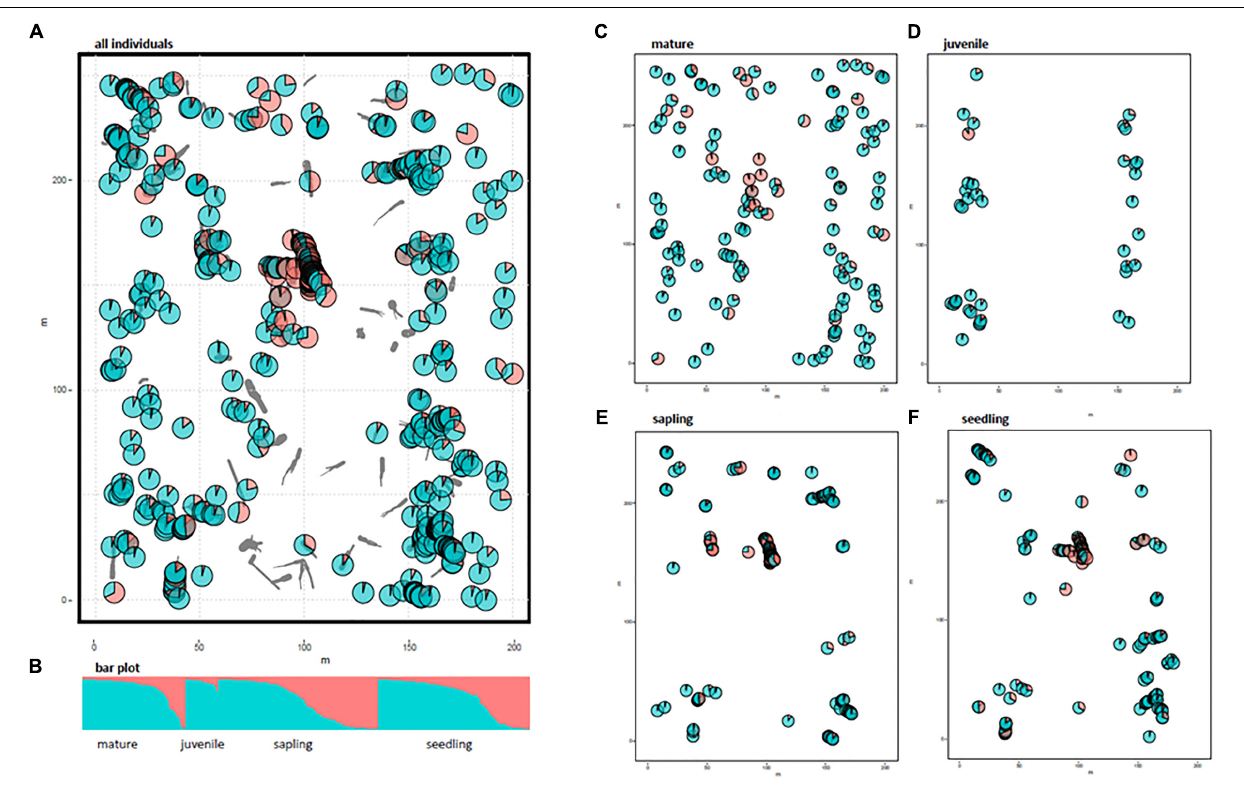
FIGURE 1 | Distribution of two cluster components of 531 individuals using STRUCTURE analysis. Gray bars indicate coarse woody debris (CWD). Pie charts represent the cluster components of each individual plant. Different colors indicate different clusters ( K = 2); Cluster 1 in red and Cluster 2 in green. (A) All 531 individuals, (B) bar plot for K = 2, (C–F) , cluster components for each growth stage without CWD